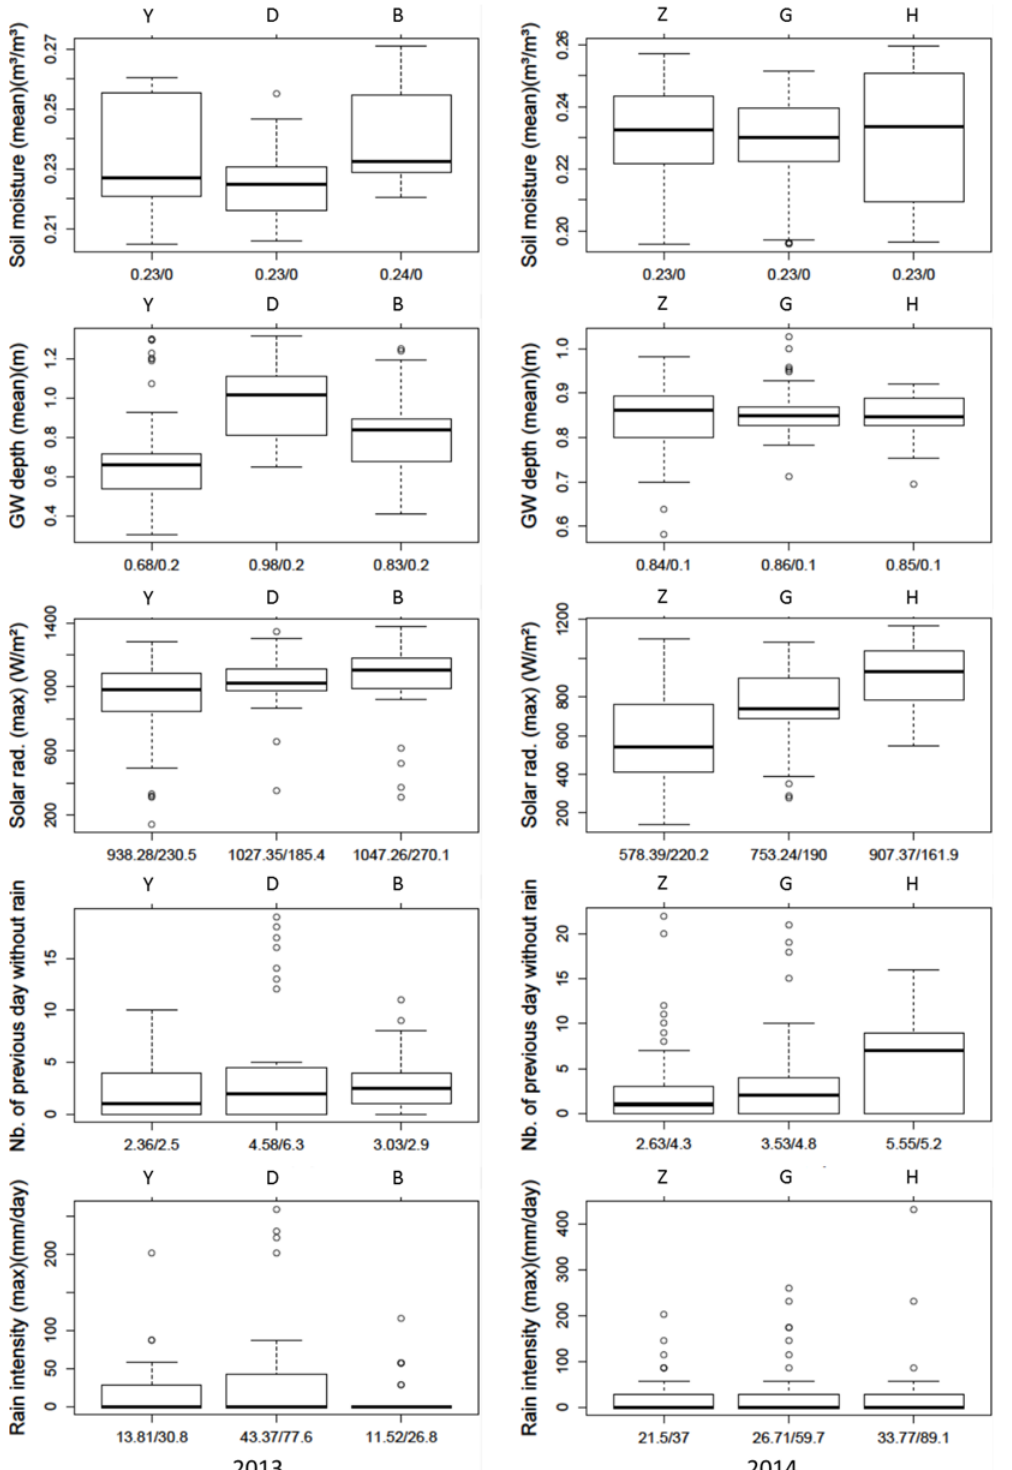
Fig 3. Boxplots of five potential drivers for each cluster. The left and right columns are, respectively, 2013 and 2014. Numbers below the graphs are the mean/standard deviation.